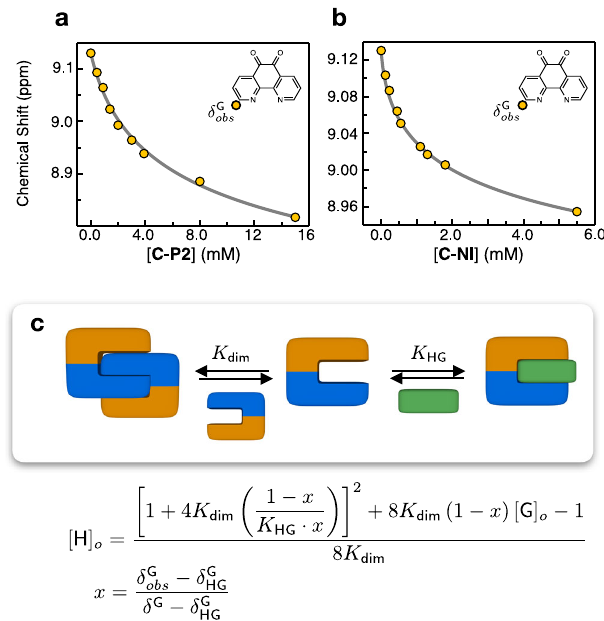
Fig. 8 Competitive π -stacking: self-association vs. host – guest complexation. Representative changes in the chemical shift of the guest ( δ G obs , annotated by a yellow circle in the chemical structure; [PHD] 0 = 0.45 mM) in CDCl 3 during titration with either a C-P2 or b C-NI at T = 298 K. The overlaid gray lines are theoretical fi ts that take into account both self-association ( K dim ) and guest encapsulation ( K HG ) of the host, as described in c : δ G HG = chemical shift of the host – guest complex (either C-P2 ⊃ PHD or C-NI ⊃ PHD ); δ G = chemical shift of the unbound guest. For each case, K HG was determined by global fi tting (see Supplementary Figs. 30 and 32). PHD